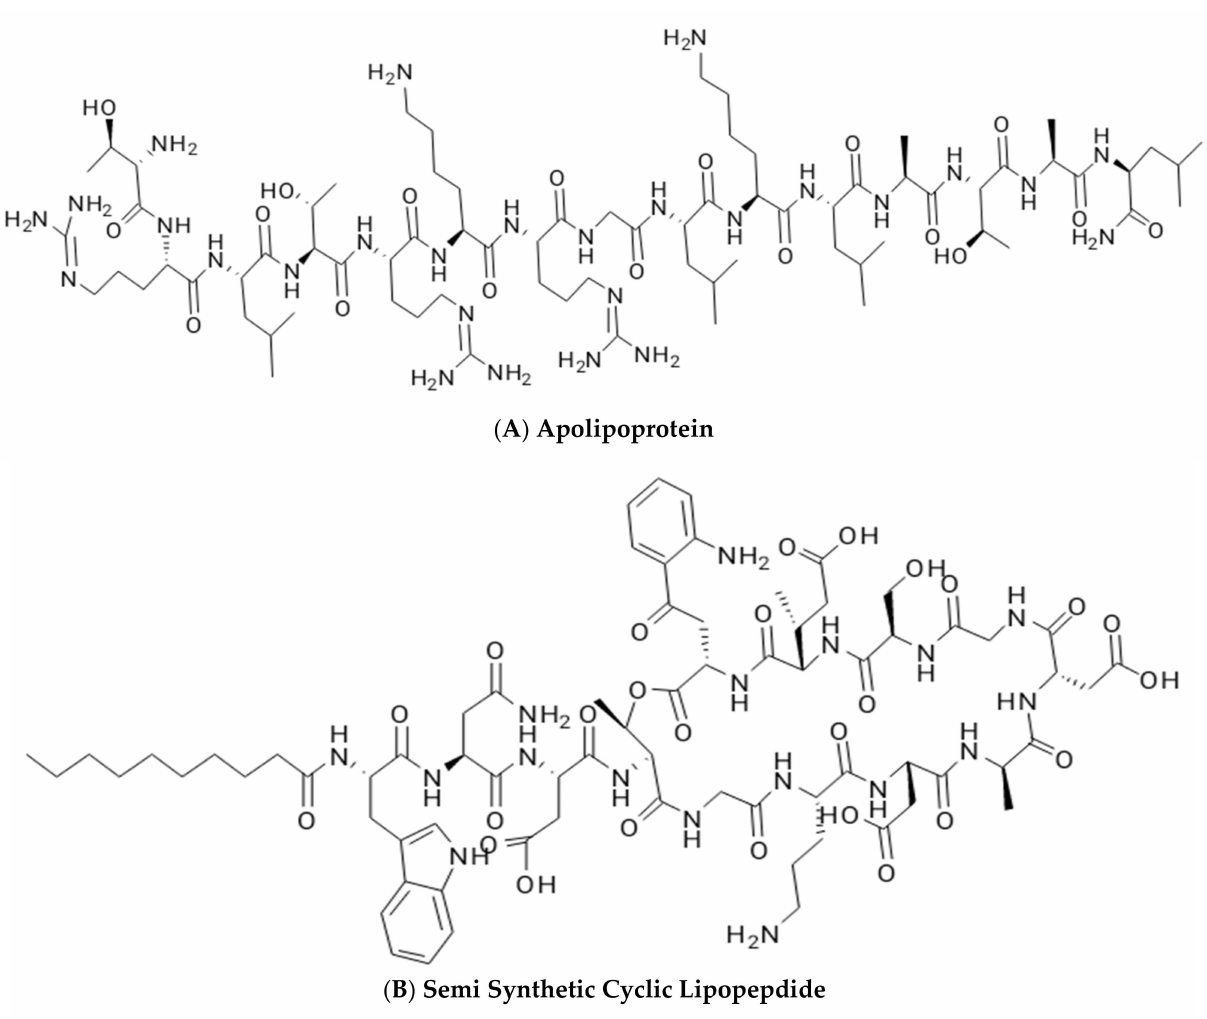
Figure 3. ( A , B ) The structure of